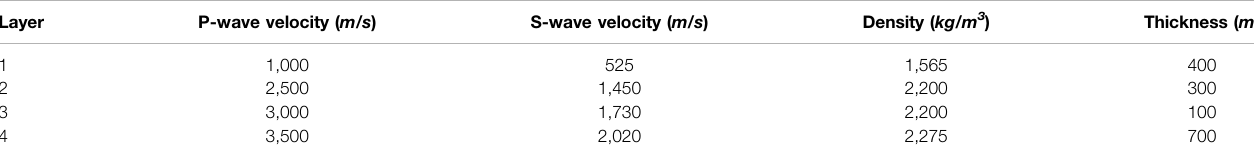
TABLE 1 | Parameters of the model.